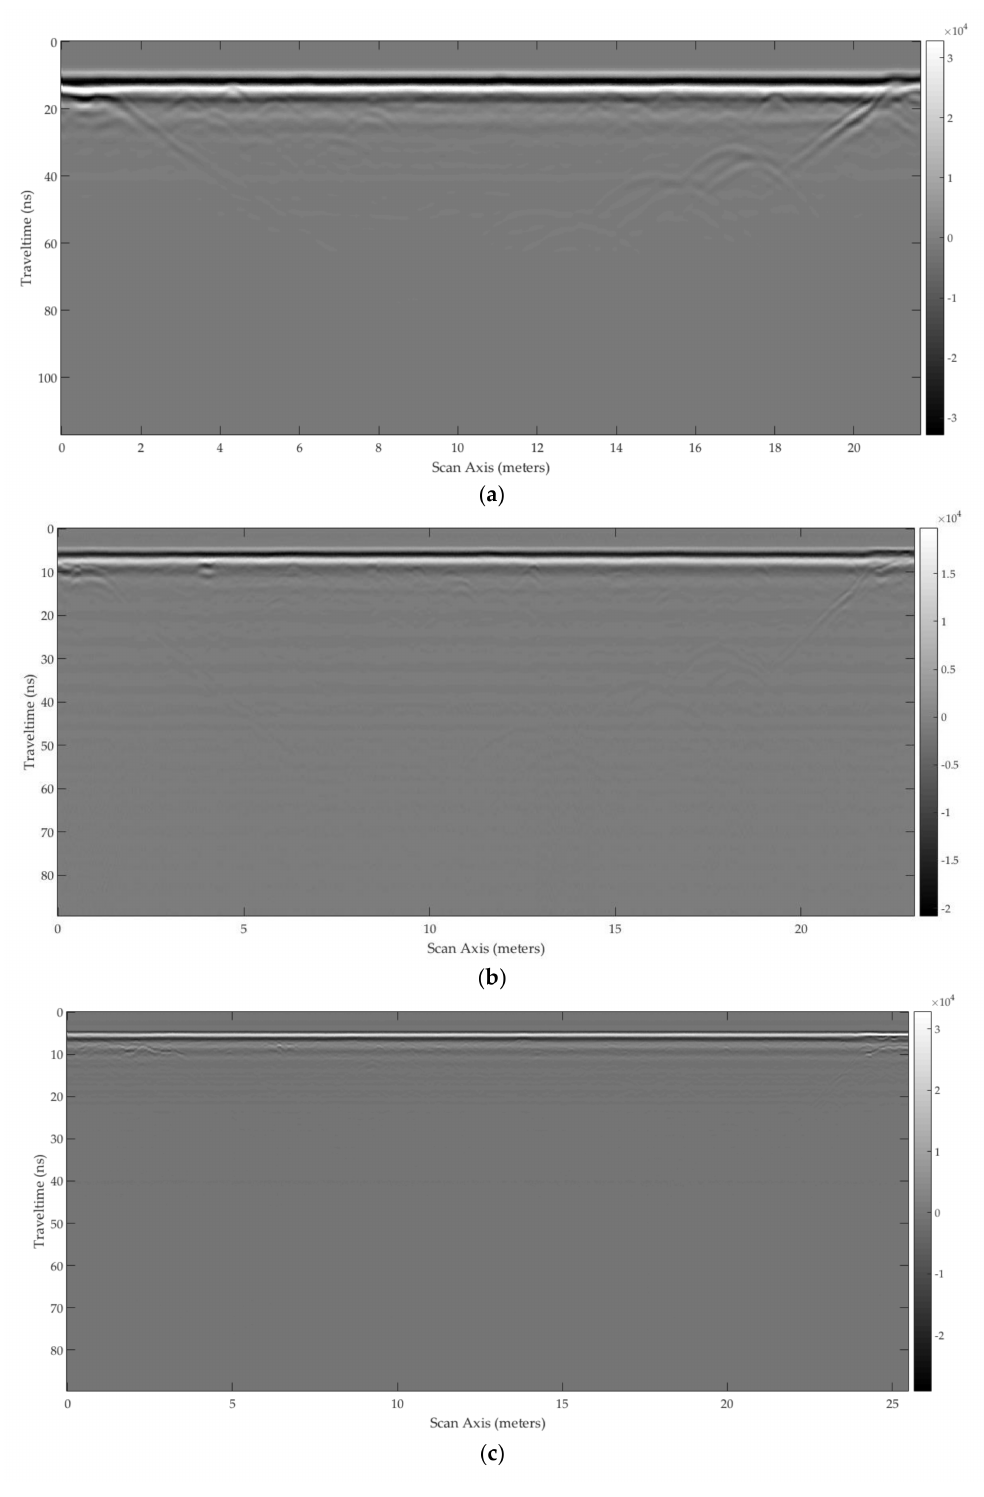
Figure 27. Profiles recorded in the limestone region by using GPR 2, on acquisition line 2, with antennas operating at: ( a ) 250 MHz; ( b ) 500 MHz; ( c ) 800